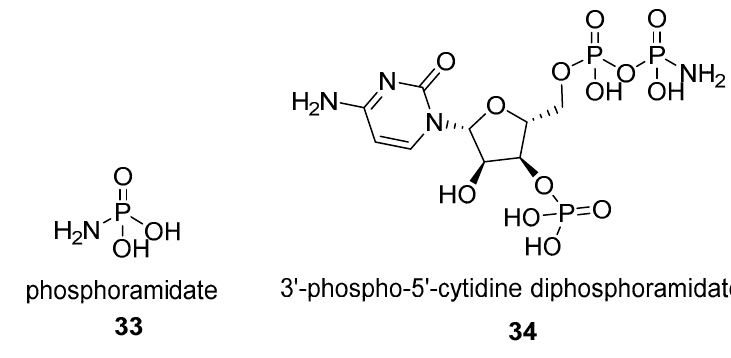
Figure 4. In vitro synthesis of AMPN compound by adenylyl transferase (EC 2.7.7.51) enzyme. AMPN can be hydrolyzed by at least two evolutionarily conserved enzymes dinucleoside triphosphatase (EC 3.6.1.29) and purine nucleoside phosphoramidase [250,251].